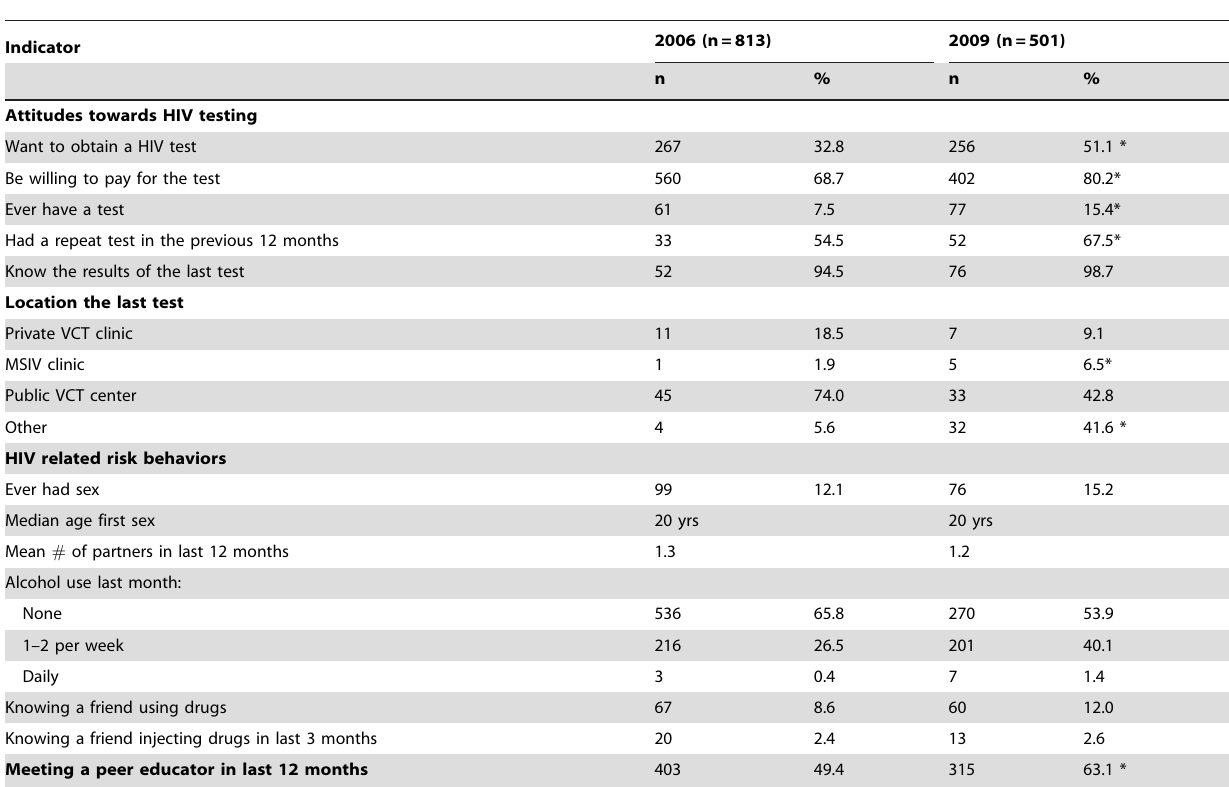
Table 3. HIV testing attitudes and experience, and HIV-related risk behaviors of community and factory